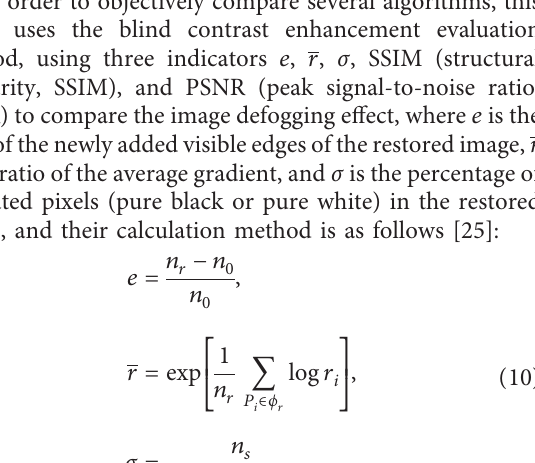
Figure 5: I -component defog reconstruction process of foggy